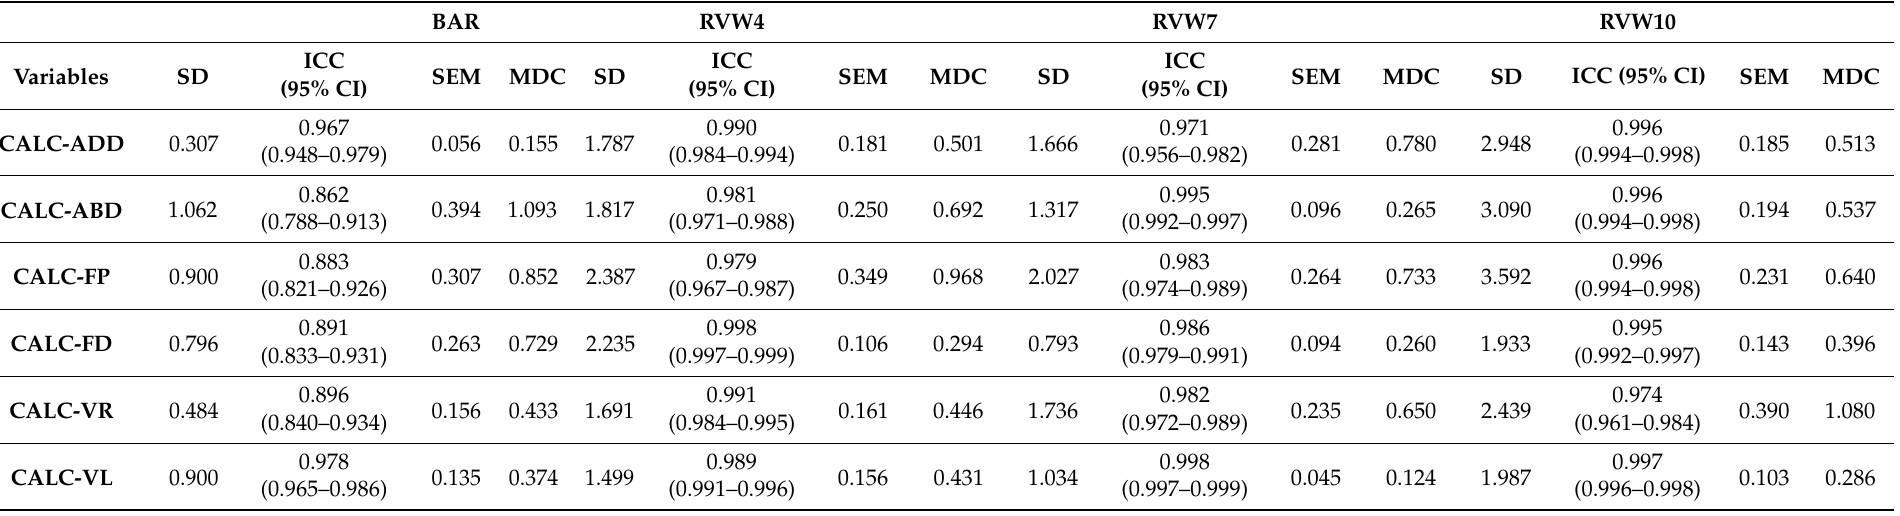
Table 4. ICC, SEM, and MDC values of the calcaneus variables in barefoot condition and wearing rearfoot varus